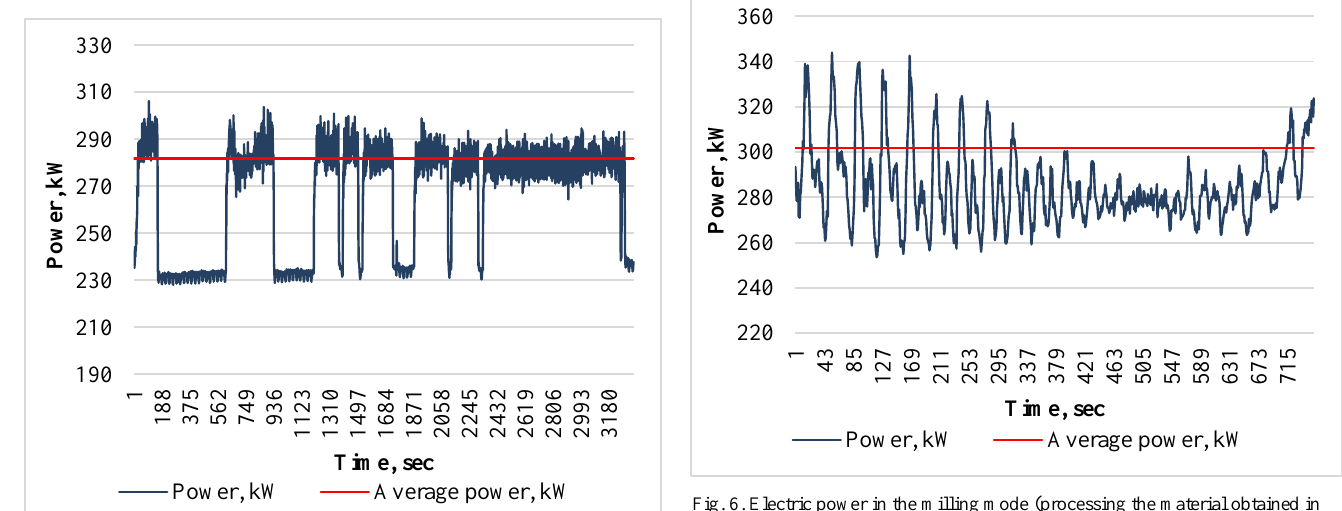
Fig. 6. Electric power in the milling mode (processing the material obtained in the pre-milling process) for modified operation scheme.